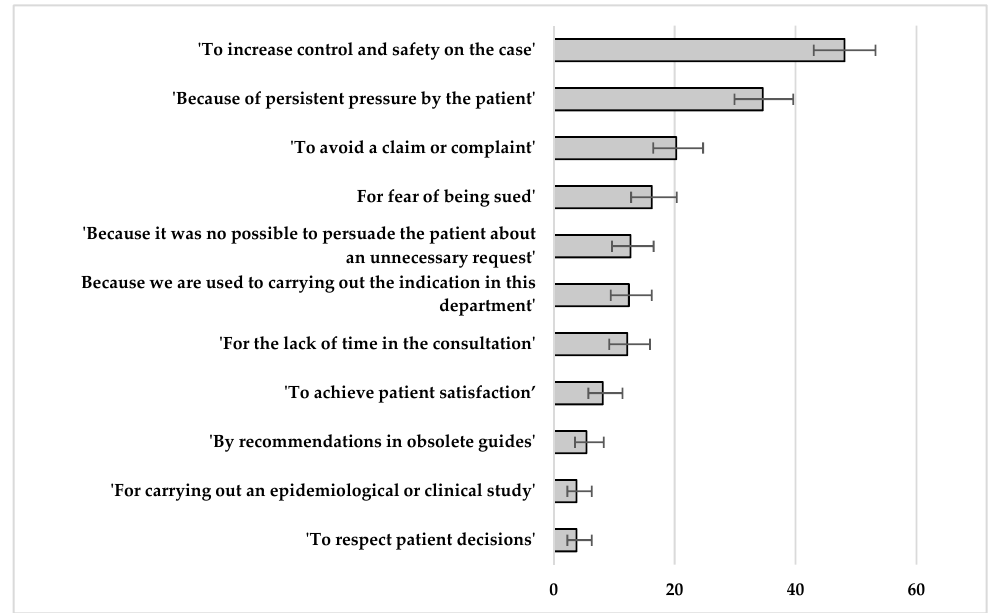
Figure 1. Main reasons why the professionals indicated unnecessary clinical procedures. Percentage of professionals who indicated each reason (including the 95% confidence intervals for each estimation).